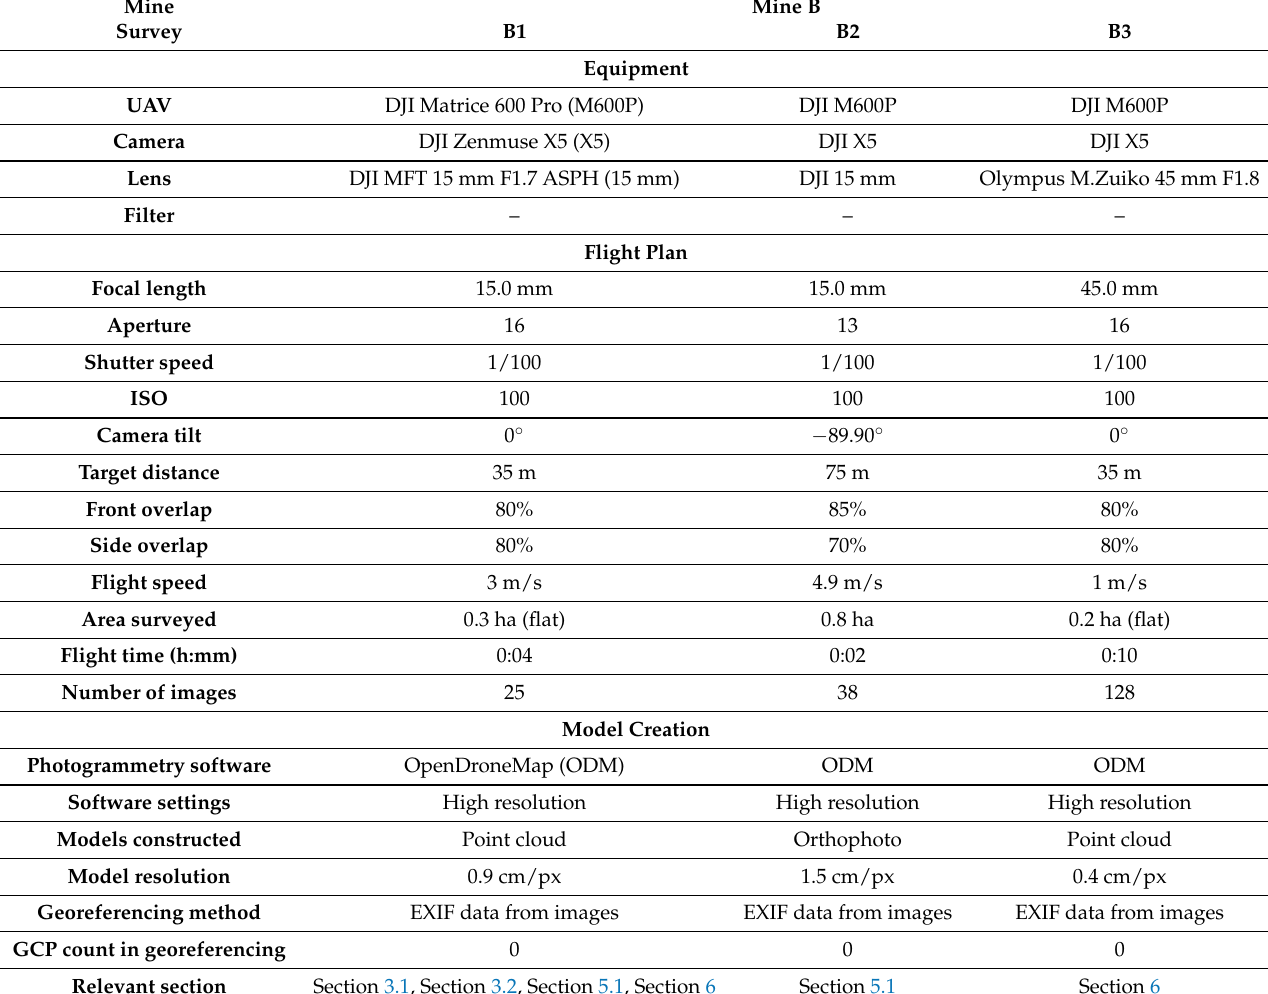
Table A2. Workflow for Mine